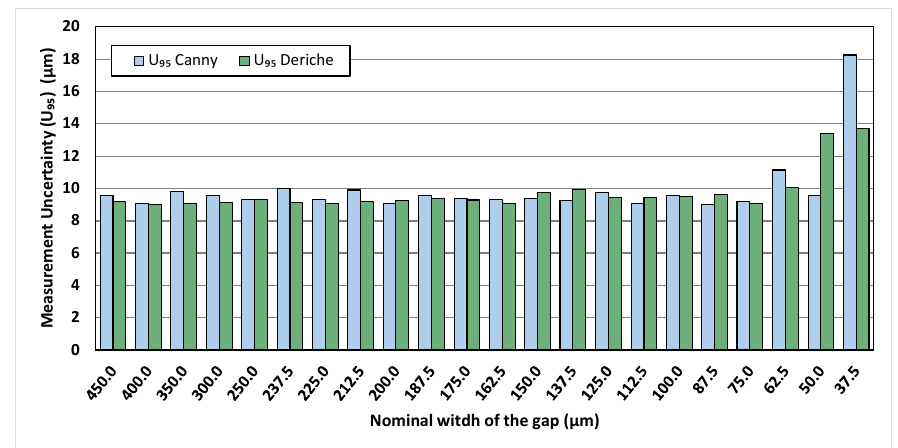
Figure 2. Expanded uncertainty values determined for CT measurements performed along the wedge air gap of the Al/Ti standard using both Canny-based and Deriche-based algorithms.